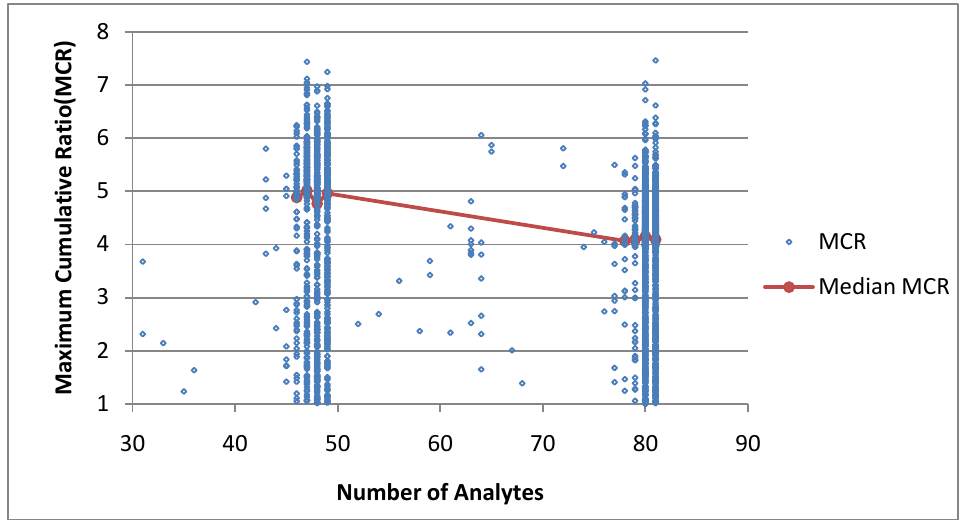
Figure 5. The relationship between MCR and n for Case 2. MCR and n have a weakly negative correlation, Kendall’s tau-b value of –0.12 (p < 0.0001) based on all samples. Correlation based on medians of grouped samples is not statistically significant (p >